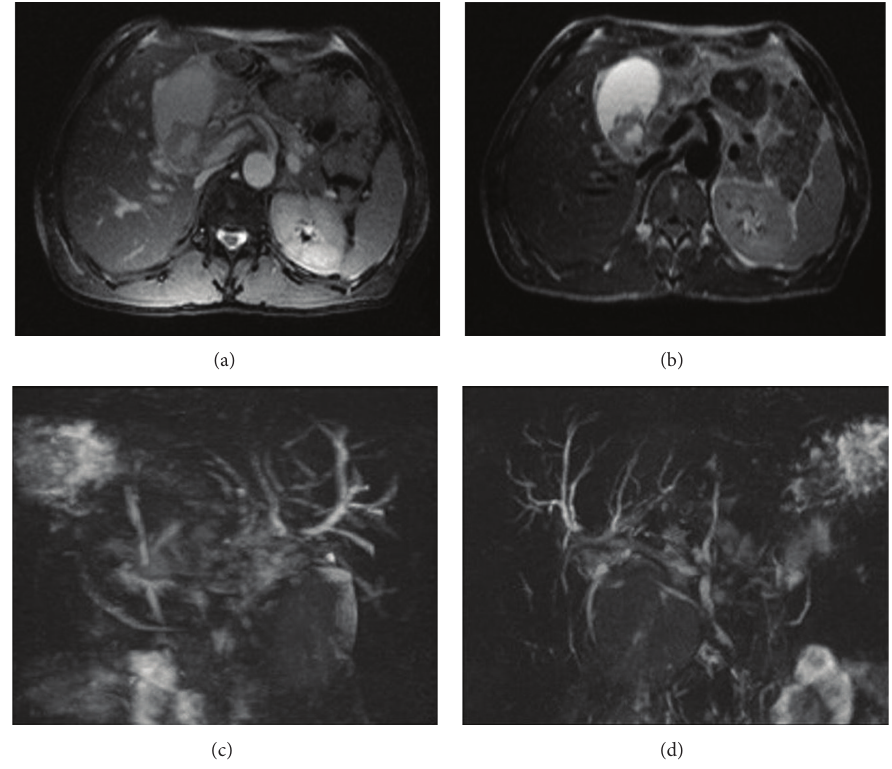
Figure 3: (a), (b) Axial fat saturated T2-weighted magnetic resonance images showing bile ducts dilatation and a fluid collection around left hepatic lobe and around gallbladder; inside the main bile duct and in the gallbladder note materials with hypointense signal due to blood clots. (c), (d) 2D and 3D haste MIP images showing low signal intensity of blood clots inside dilatated bile tree, sign of haemobilia, and inflammatory narrowing of distal choledocus.